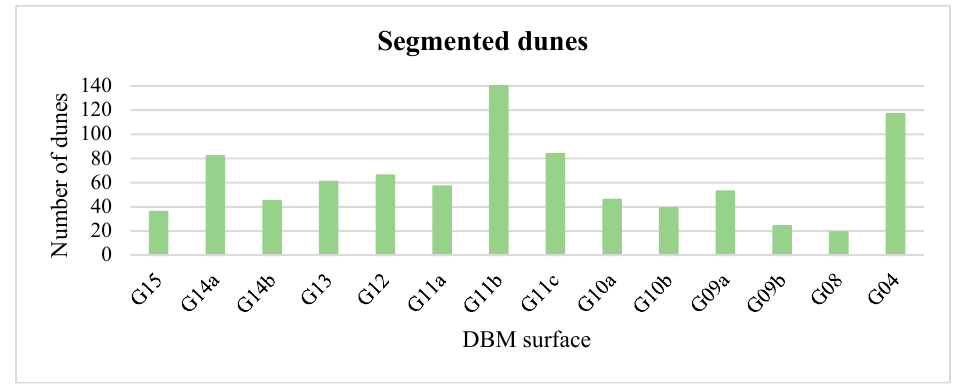
Figure 11. Number of segmented dunes by DBM surface.